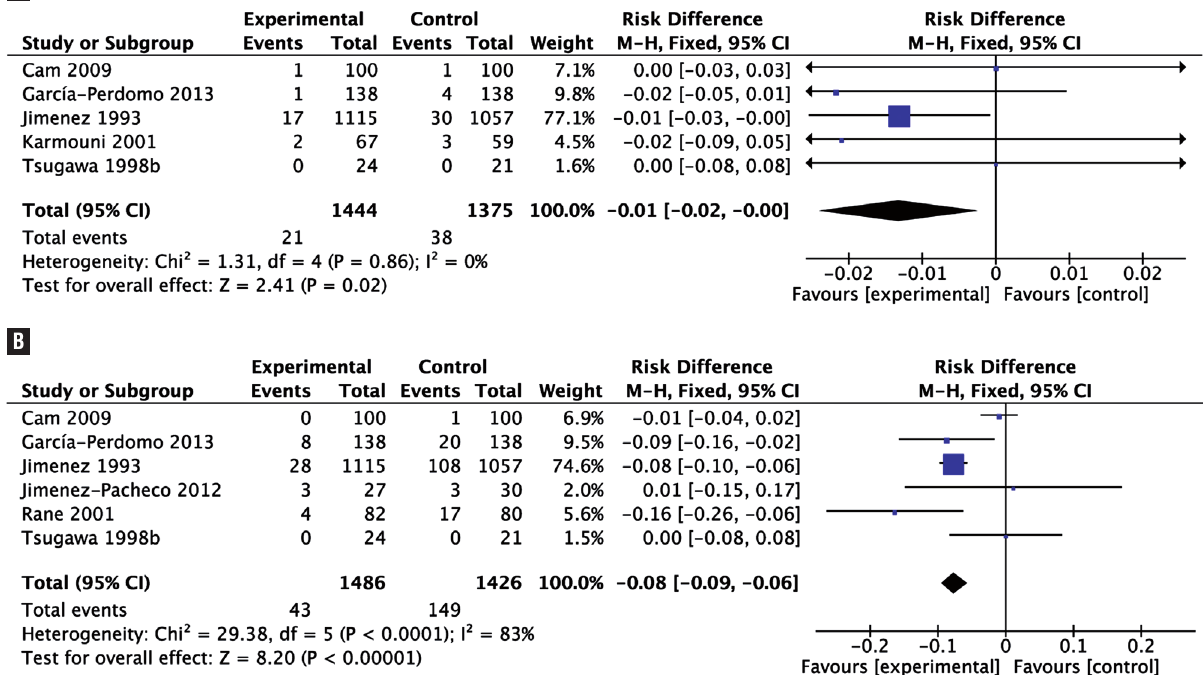
Figure 2 - Forrest plot for antibiotic versus any other intervention, outcome: A. urinary tract infection B. asymptomatic